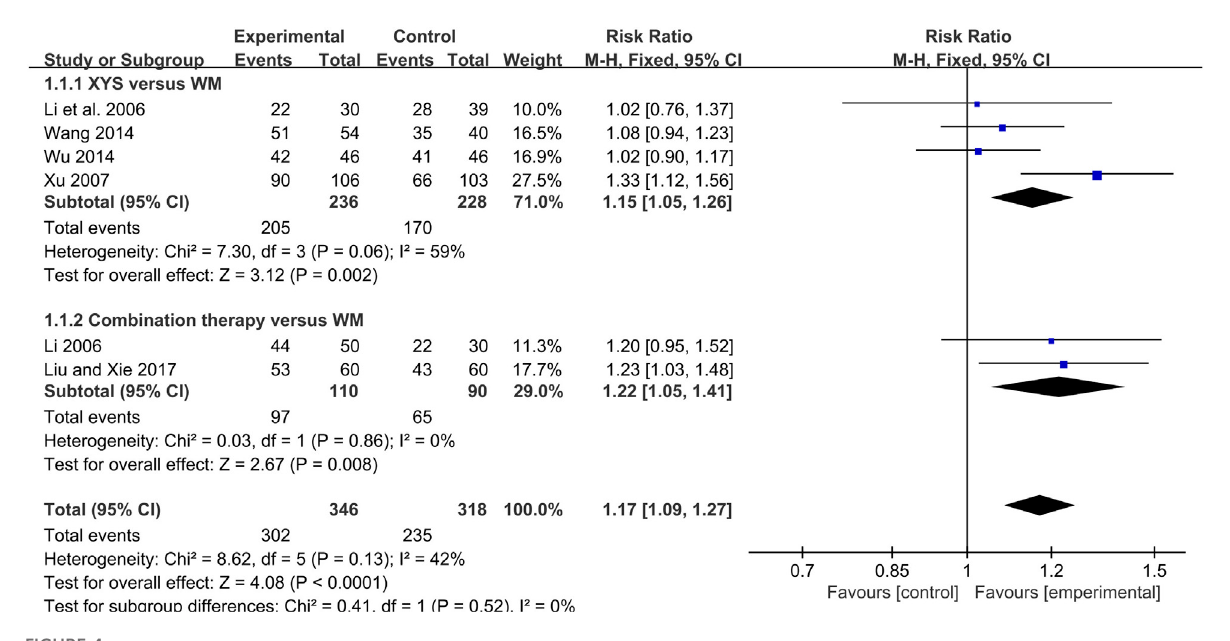
FIGURE 4 Forest plot of the comparison for total clinical ef fi cacy rate between the XYS and WM